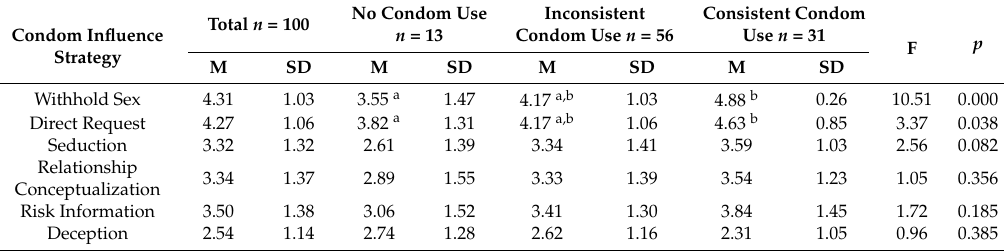
Table 3. Frequency of condom use and condom influence strategies of minority college women. Total n = Condom Influence Strategy